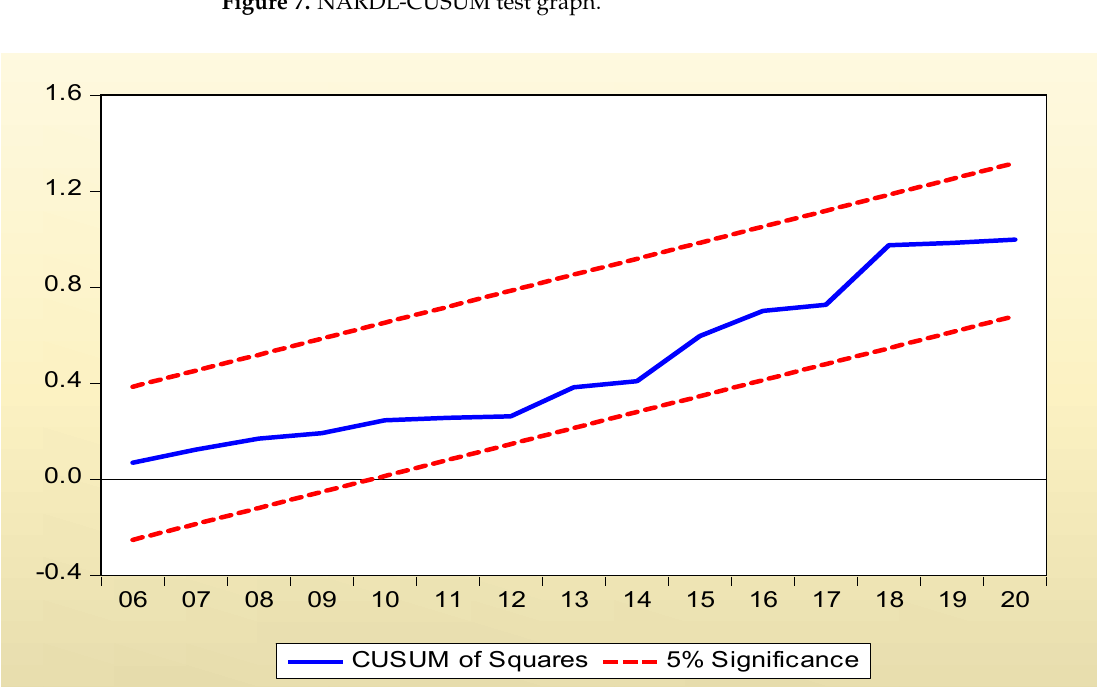
Figure 8. NARDL-CUSUM of